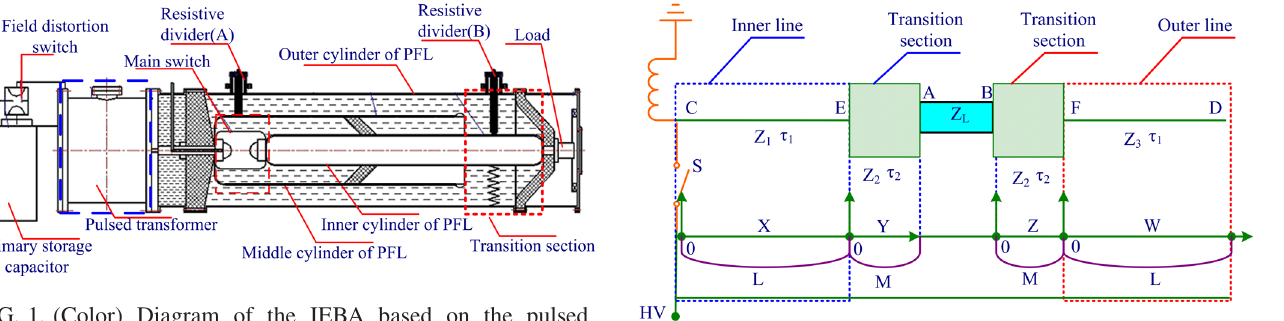
FIG. 2. (Color) Equivalent circuit of the BPFL discharge into the